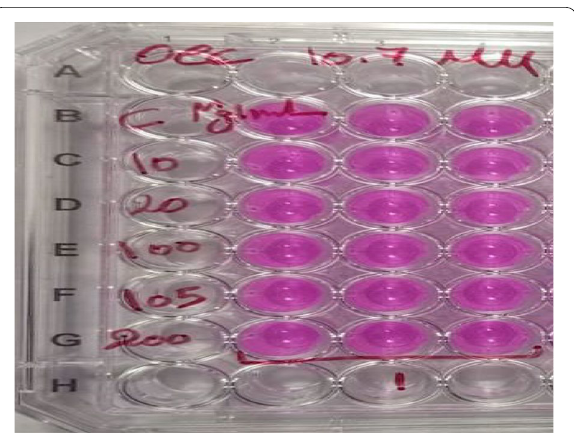
Fig. 2 Cytotoxicity assay of apricot oil extract on normal OEC using SRB